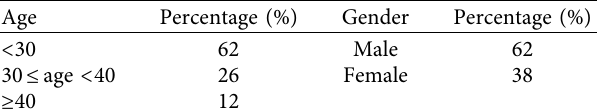
Table 8: Composition of